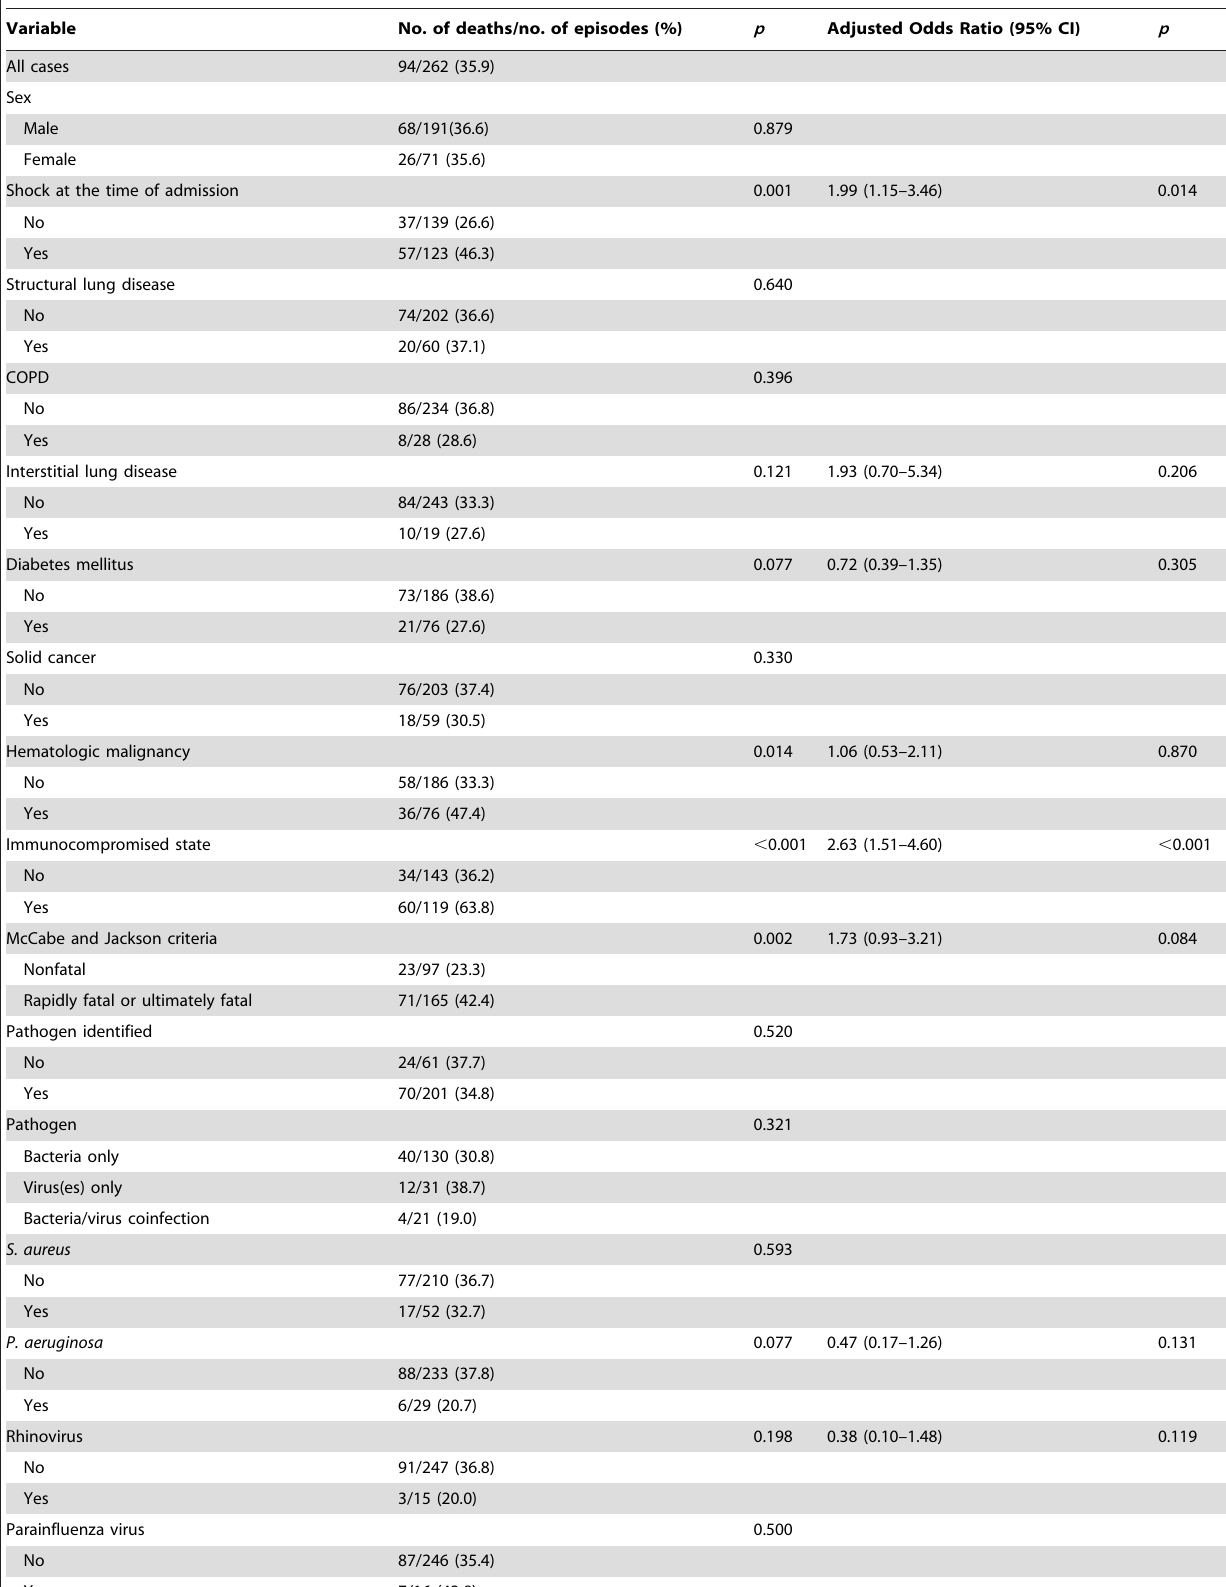
Table 5. Twenty-eight day mortality risk of patients with severe pneumonia.